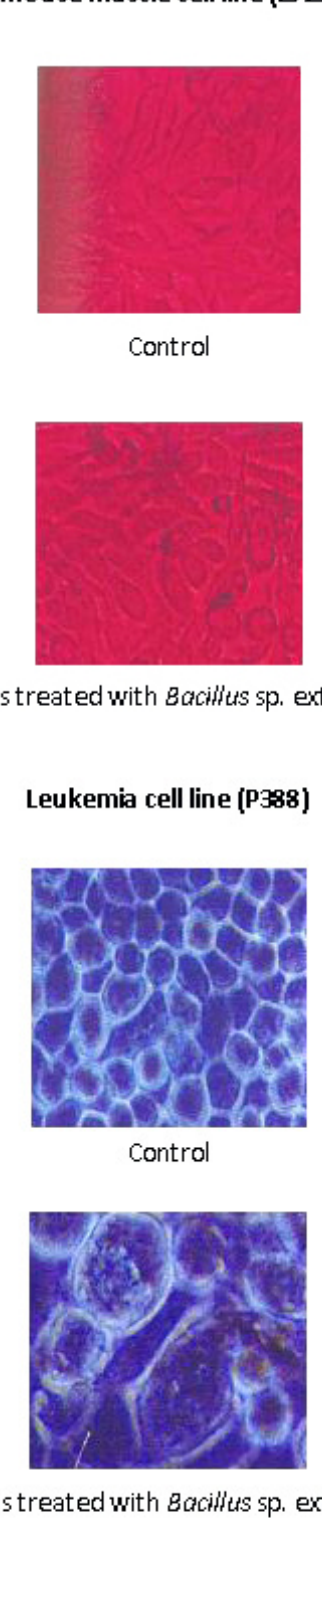
Figure 3. Growth inhibitory activity of Bacillus sp. bacterial crude extract obtained from Arothron hispidus liver against two cell